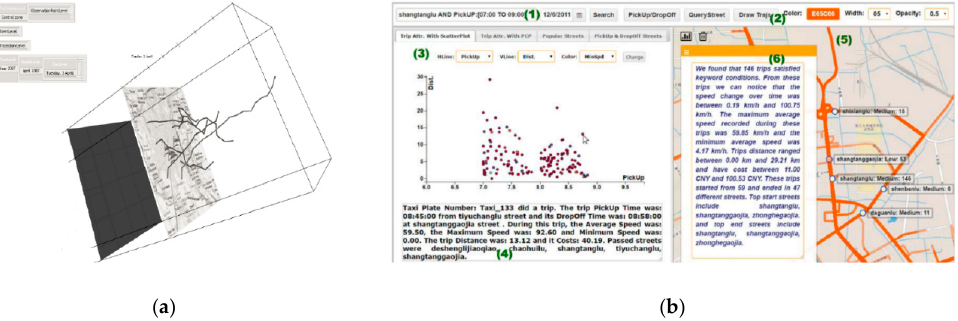
Figure 5. Examples of analyzing trajectory semantic patterns: ( a ) encoding downtown pedestrian trajectories by semantic types [11]; and ( b ) visually exploring taxi trajectories via SemanticTraj [12–14].